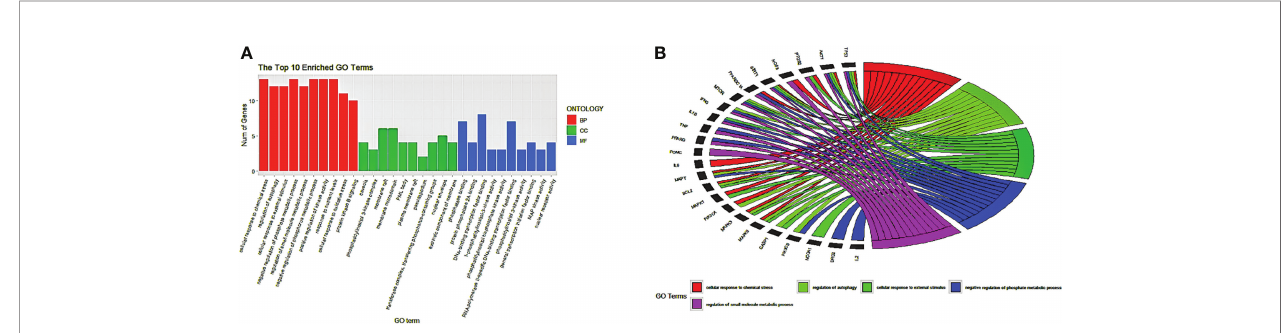
FIGURE 5 | GO enrichment analysis and top fi ve biological processes. (A) GO enrichment analysis. Top 10 signi fi cantly enriched terms of each part. BP, biological process; CC, cellular component; MF, molecular function. (B) The top 5/10 enriched biological processes.